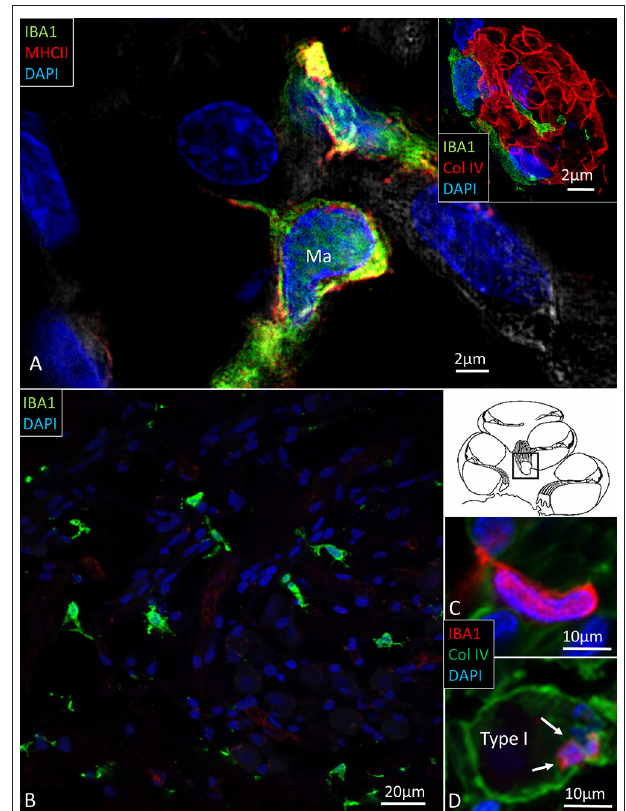
FIGURE 4 | (A) SR-SIM of IBA1 cells co-expressing MHCII in the human spiral ganglion. IBA1 cells mingle with Schwann cells in a peripheral axonal bundle (inset). (B) Confocal microscopy of several branched IBA1 macrophages is seen in the spiral ganglion. (C) The macrophages have nuclei expressing IBA1 protein. (D) The basal lamina surrounding the satellite cells expresses collagen IV. A macrophage (arrows) is closely related to the satellite glia cell surrounding a type I ganglion cell. The IBA1 cell is seen to cross the basal